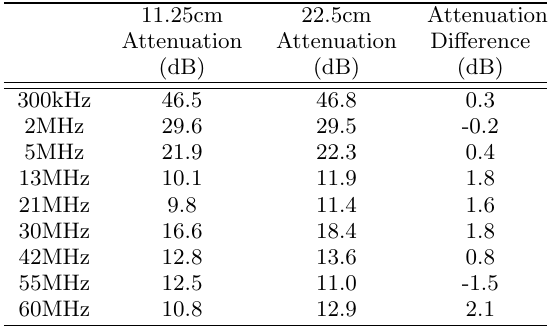
Table 2: Channel attenuation in phantom solution for each transmission frequency. Attenuation dif- ference shown is the difference in attenuation for d = 11 . 25 cm and d = 22 . 5 cm .